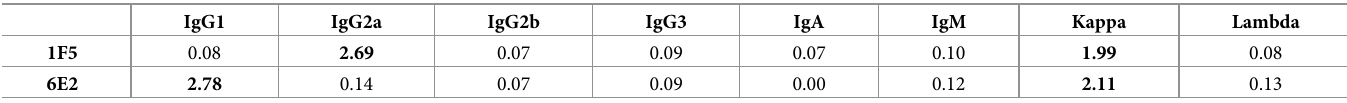
Table 1. Isotypes of 1F5 and 6E2